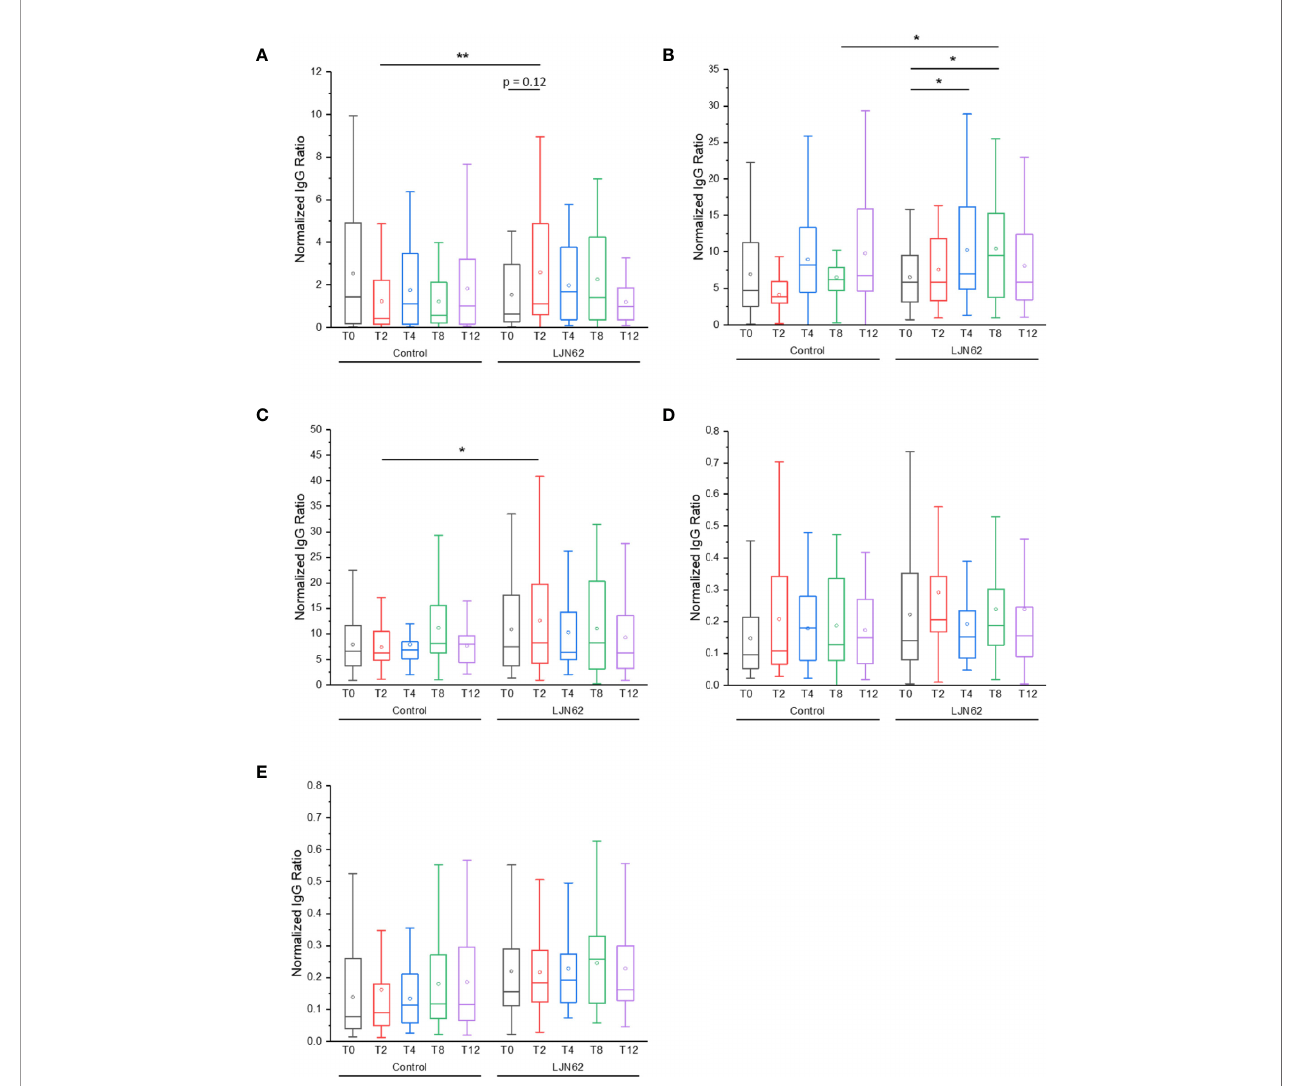
FIGURE 9 | IgG ACAb generation against L. johnsonii N6.2 proteins and NV. Normalized IgG ratio of speci fi c IgG generated against the antigens, NV (A) , Sdp_SH3b2 (B) , Sdp_SH3b6 (C) , Eno3 (D) and LexA (E) , over total plasma IgG. *p < 0.05 and **p <